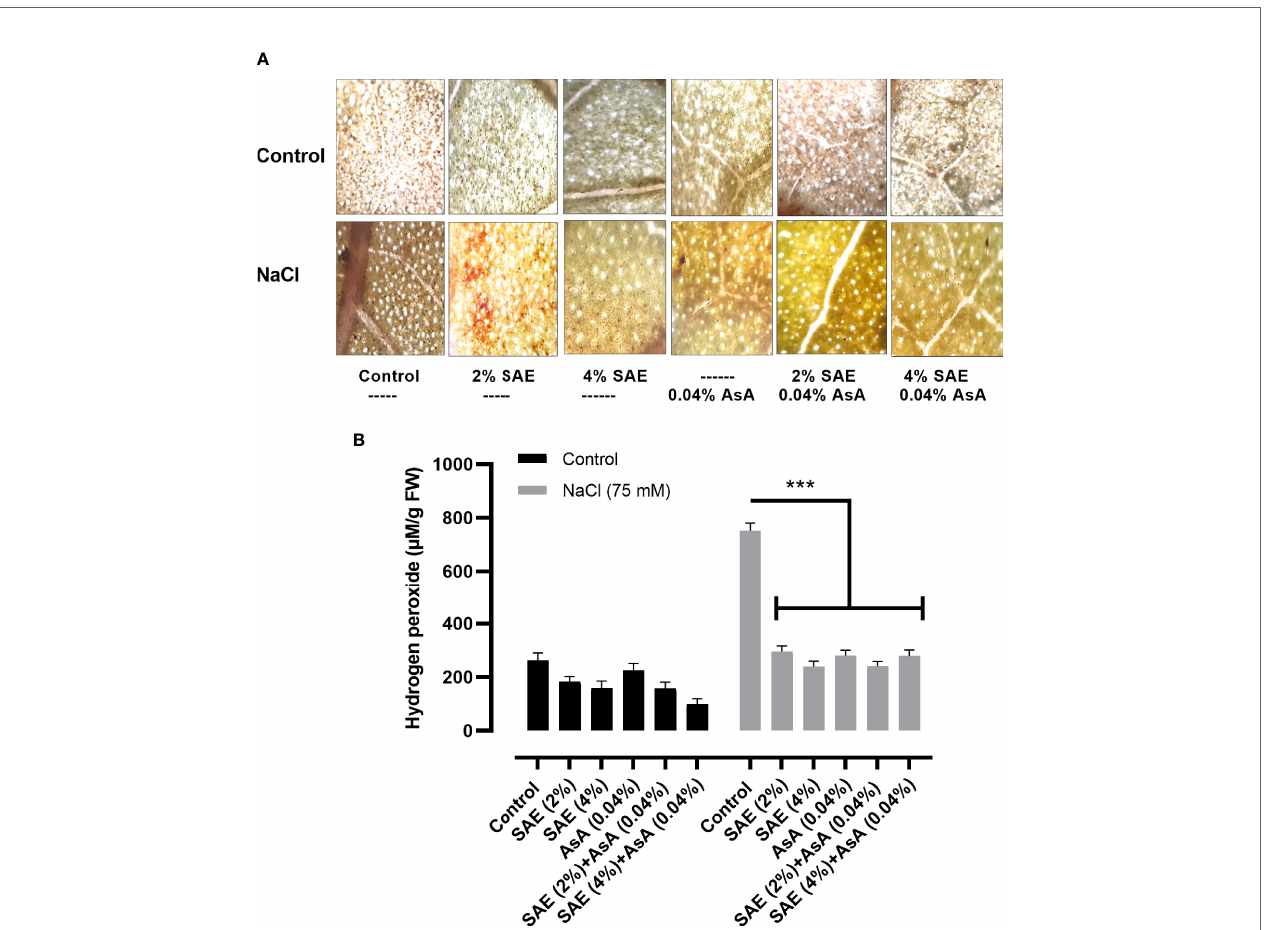
FIGURE 9 | Histochemical analysis for H 2 O 2 quanti fi cation. (A) DAB staining for H 2 O 2 detection; (B) H 2 O 2 quanti fi cation. Error bars of quantitative data represent ± SEM (*** p < 0.005). FW, fresh